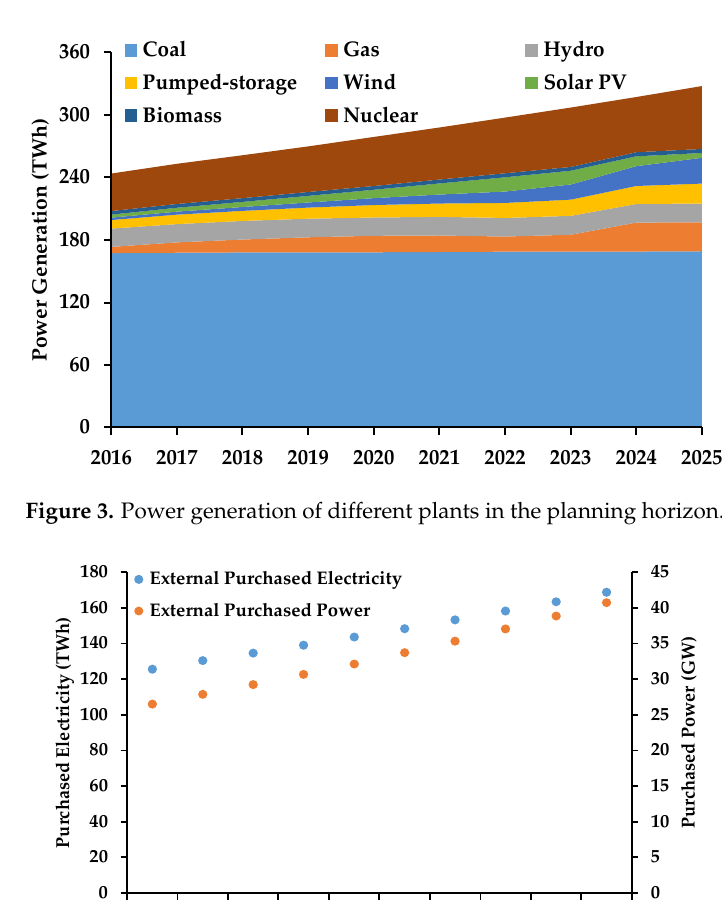
8 of 15 Figure 2. Proportions of installed capacities in the planning horizon. The optimal power development planning for Zhejiang Province from 2016 to 2025 can be obtained from the PGE-Zhejiang model, including optimal power generation mix, external purchased electricity, and external purchased power. As shown in Figure 3, as the demand for electricity continues to increase, power generation increases year by year, from 243.80 TW-h in 2016 to 327.59 TW-h in 2025. Meanwhile, coal-fired plants will continue to provide stable electricity output, ensuring the basic electricity demand in Zhejiang Province. Although the total installed capacity of the nuclear power plants accounts for only 9.56% of the total installed capacity during the planning horizon, its power generation capacity is only ranked after the coal-fired plants and has become another major source of maintaining the balance of supply and demand in Zhejiang’s power system. In addition, renewable energy technologies will also make a significant contribution to the electricity demand in Zhejiang, which may provide the maximum ‘about 6.18%’ of power generation during the planning horizon. In fact, biomass power plants are often overlooked in some power planning studies, but this does not indicate that they are not important. Although they provide only 37.18 TW-h (1.31% of the total) during the planning horizon, their role in reducing environmental pollution due to large amounts of straw burning is indispensable. However, they usually cannot